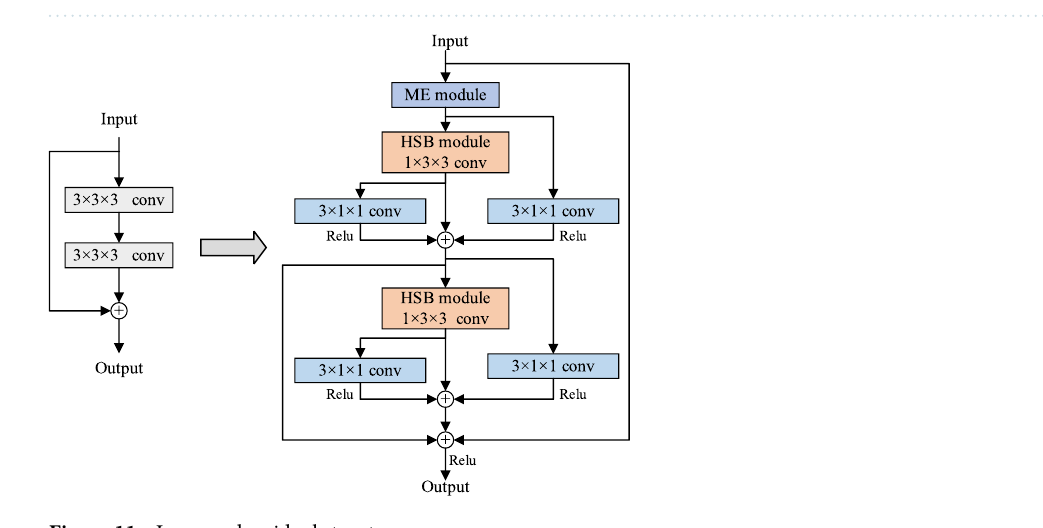
Figure 11. Improved residual